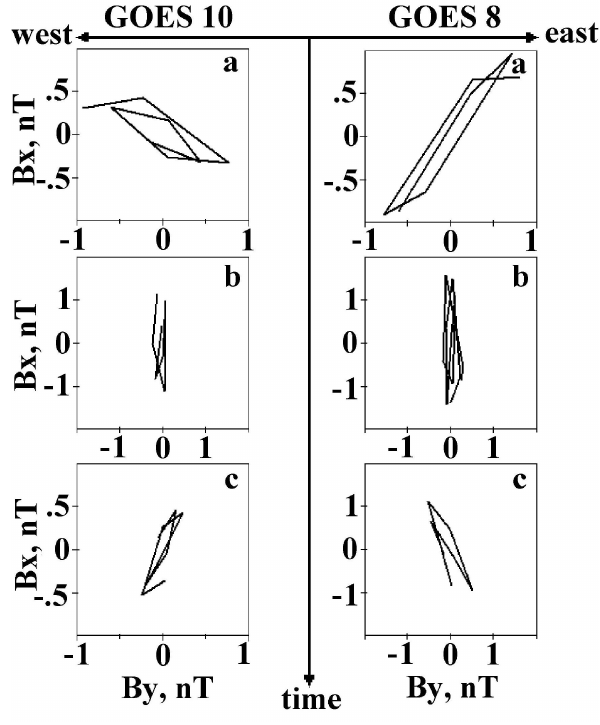
Fig. 4. The hodograms of the waves detected by GOES 10 (left) and GOES 8 (right) in the 200–250s